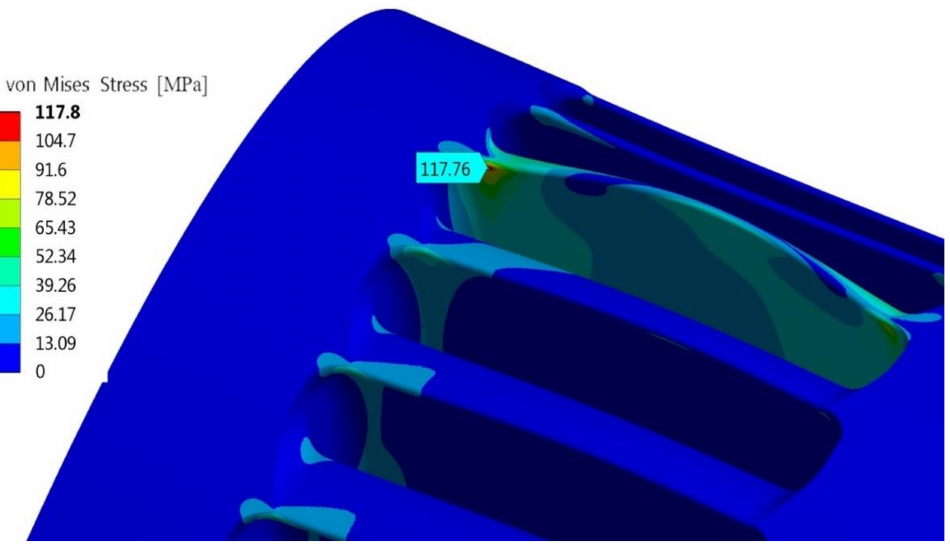
Figure 16. von Mises stress for impeller